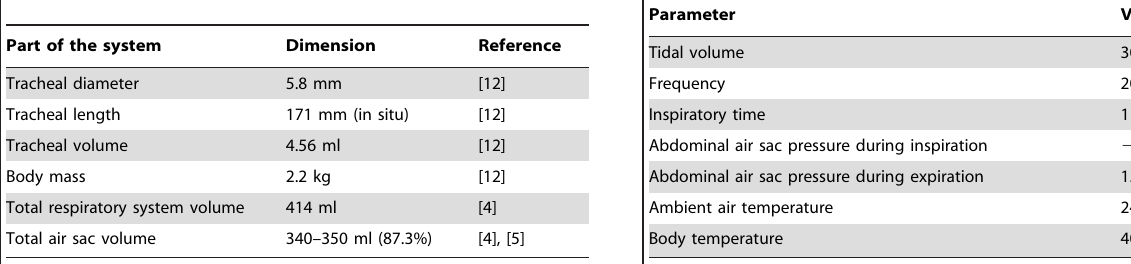
Table 1. Anatomical data for the domestic fowl.